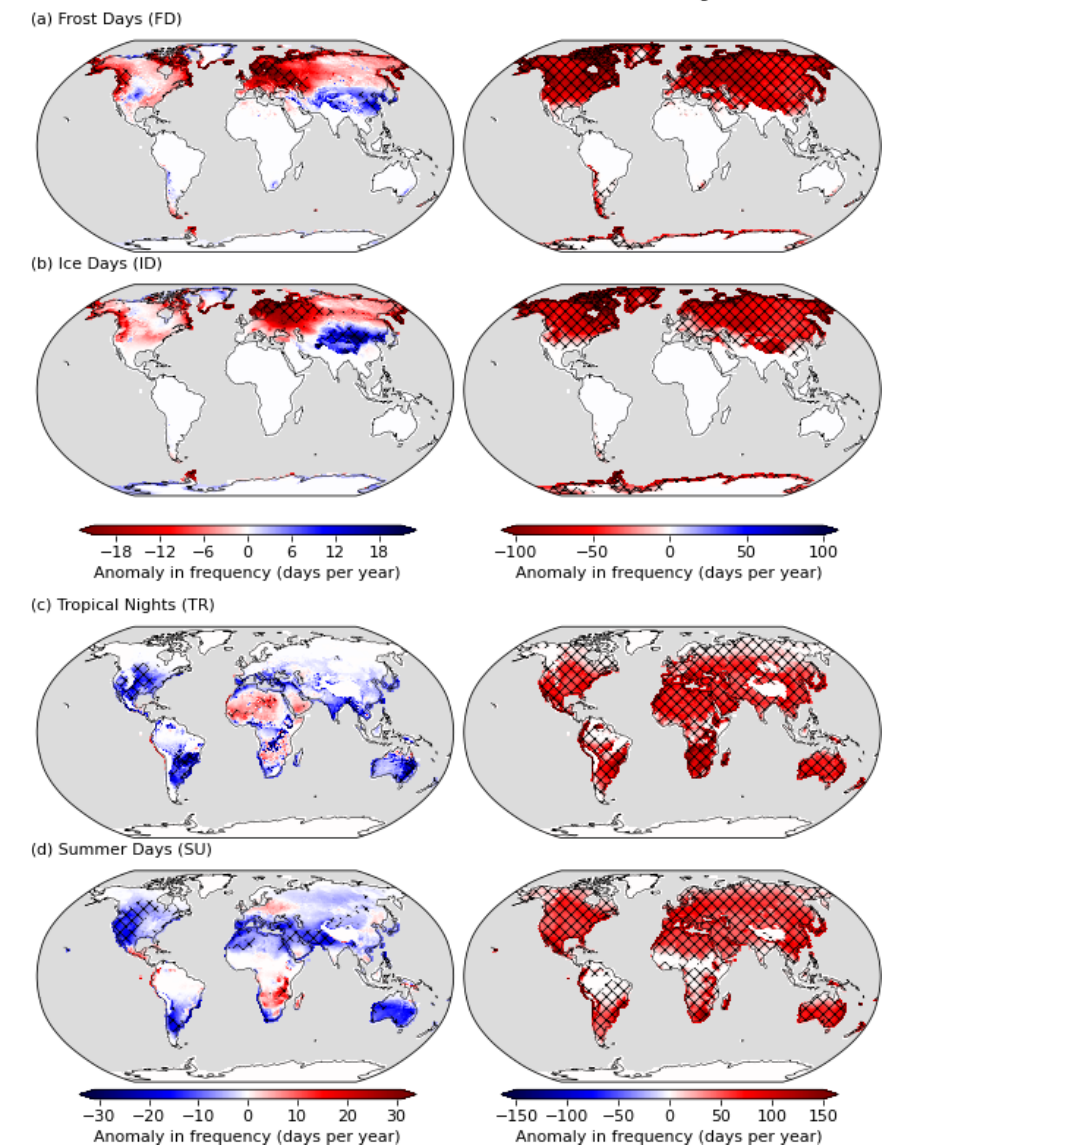
Figure 4. The same as Fig. 2, but containing projected anomalies in the frequency of daily minima < 0 ◦ C (frost days, FD), daily max- ima < 0 ◦ C (ice days, ID), daily minima > 20 ◦ C (tropical nights, TR), and daily maxima > 25 ◦ C (summer days, SU). Hatching indicates significance at the 5% test level using the Student’s t